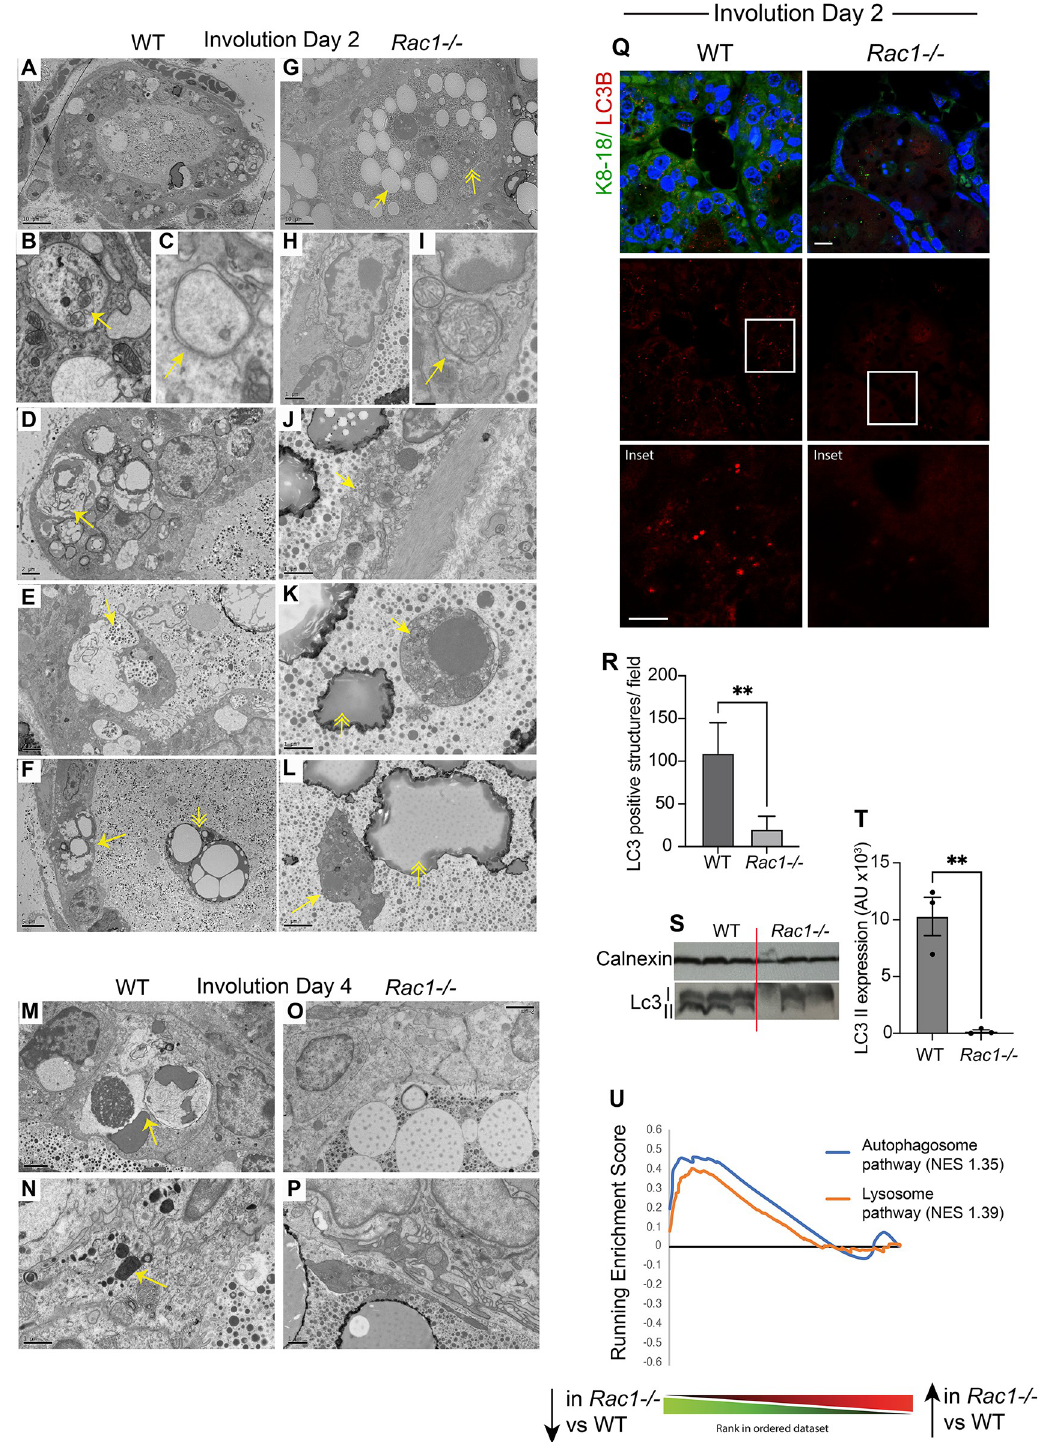
Fig 6. Rac1 mediates cell death with autophagy but not programmed cell death. Electron micrographs of WT ( A - F ) and Rac1 −/− ( G - L ) involution day 2 glands. ( A ) WT alveolus showing engulfment activity with numerous phagosome-like structures within the epithelium. Bar: 10 μ m. ( B , C ) Autophagosomes in WT luminal cells. Note mitochondria in autophagosomes ( B ; arrow) and characteristic double membrane structures ( C ; arrow). ( D ) Autophagosomes and phagosomes containing milk lipids (arrow) in WT cells. Bar: 2 μ m. ( E ) Macropinosomes engulfing milk (arrow) in WT cells. Bar: 2 μ m. ( F ) Engulfed milk lipid